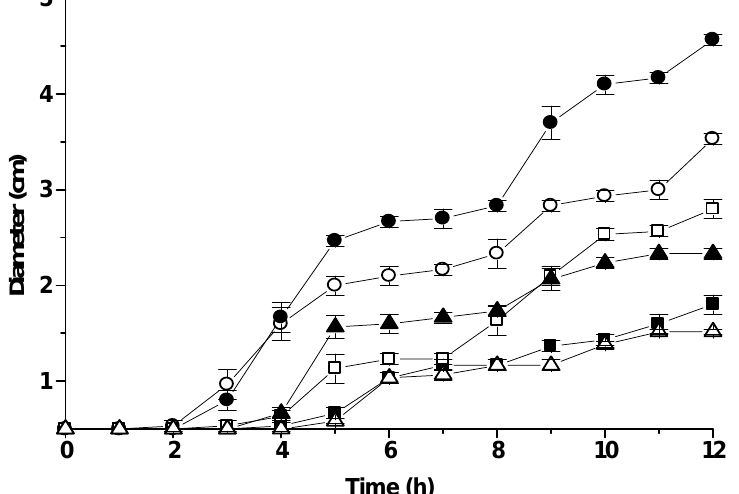
Figure 3 . Effect of selected monoterpenes on the swarming behavior of Proteus mirabilis (L68 wild strain): (cid:122) control (no terpenes), (cid:123) pulegone (0.5 mg/L), (cid:83) citral (0.5 mg/L), (cid:85) geraniol (0.3 mg/L), (cid:132) citronellol (0.3 mg/L), (cid:133) α -terpineol (0.5mg/L). The data represent the averages of colony diameter of three independent experiments with standard deviations.